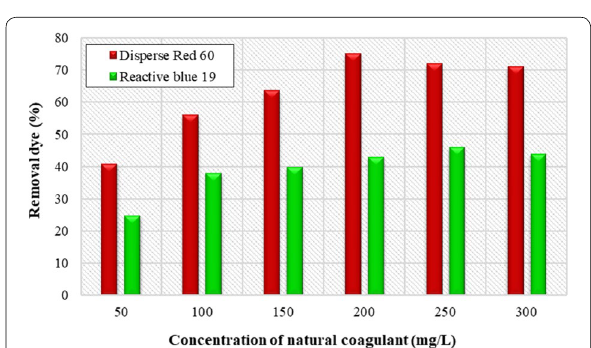
Fig. 3 Effect of Alcea rosea concentration on removal efficiency of Disperse red 60 and Reactive blue 19 dyes. (Initial pH dye concentration 40 mg/L) =